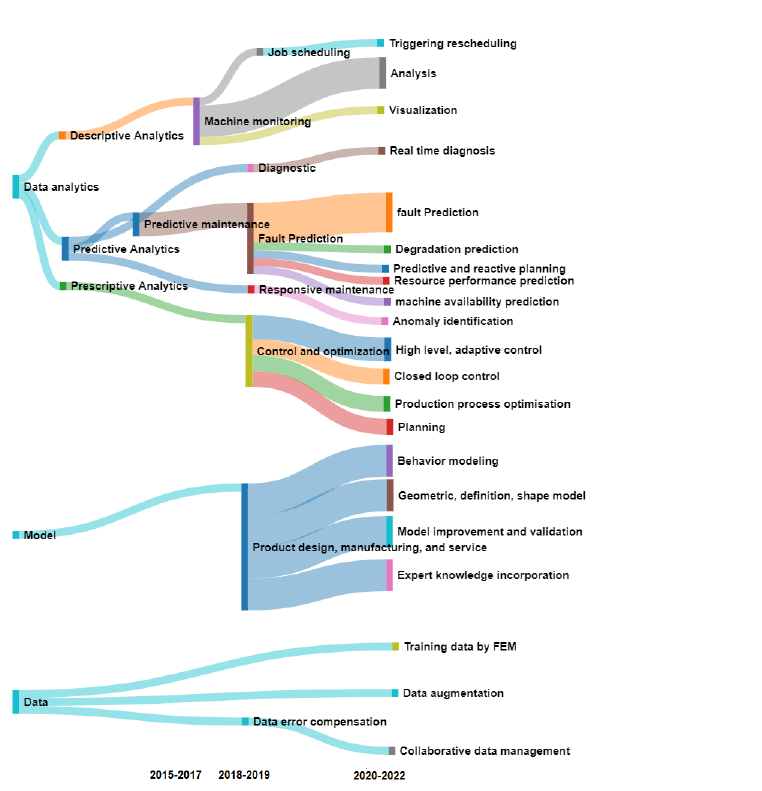
Figure 14. Evolution of tasks performed by ML algorithm. A sanky diagram showing evolution of the task over three periods of